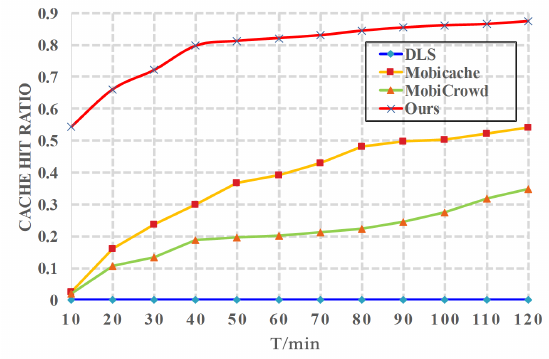
Figure 6. Cache Hit Ratio vs. t